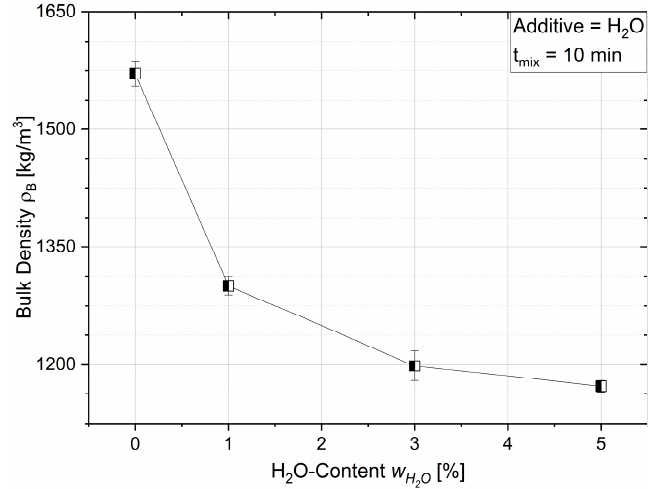
Figure 7. Bulk density as a function of the water content by weight.